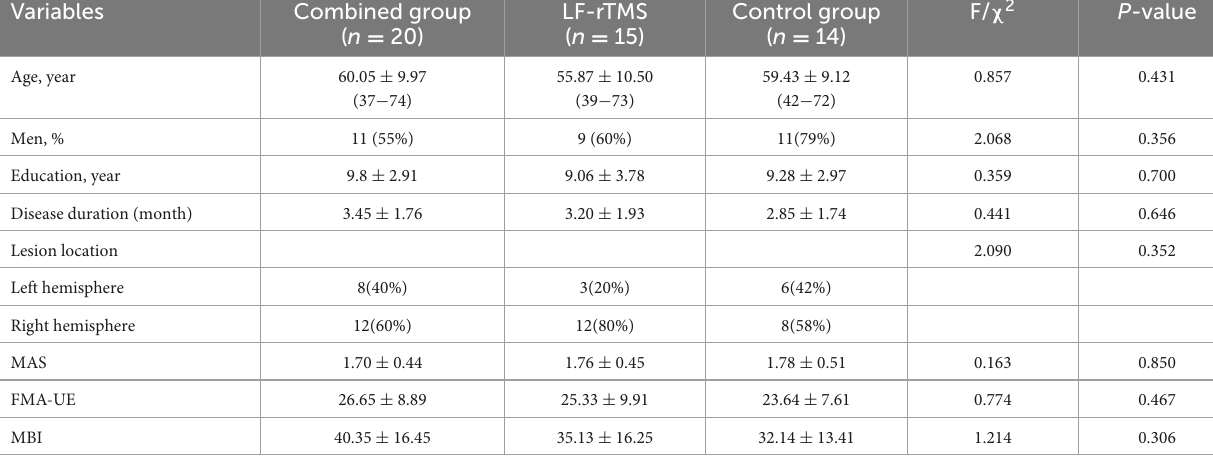
TABLE 1 Baseline characteristics of stroke